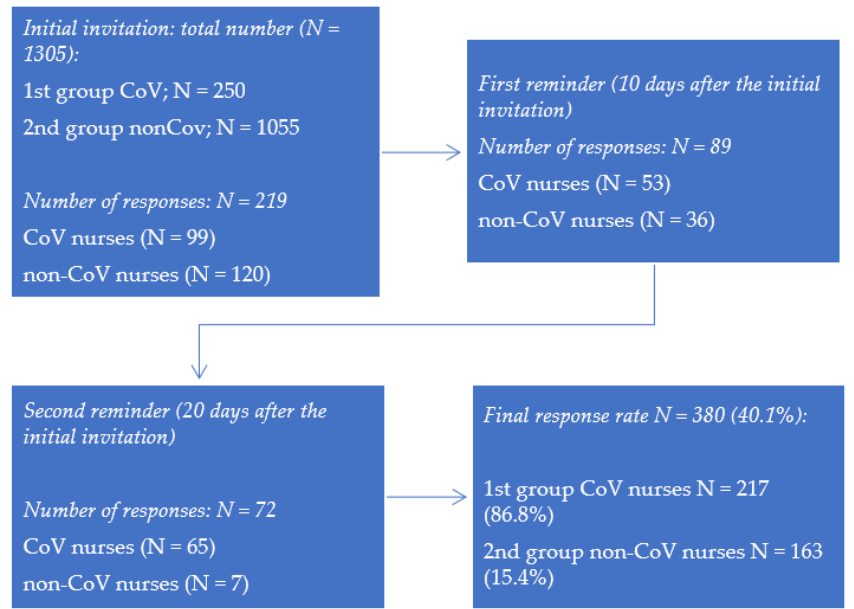
Figure 1. Flow chart of data collection and response rates.